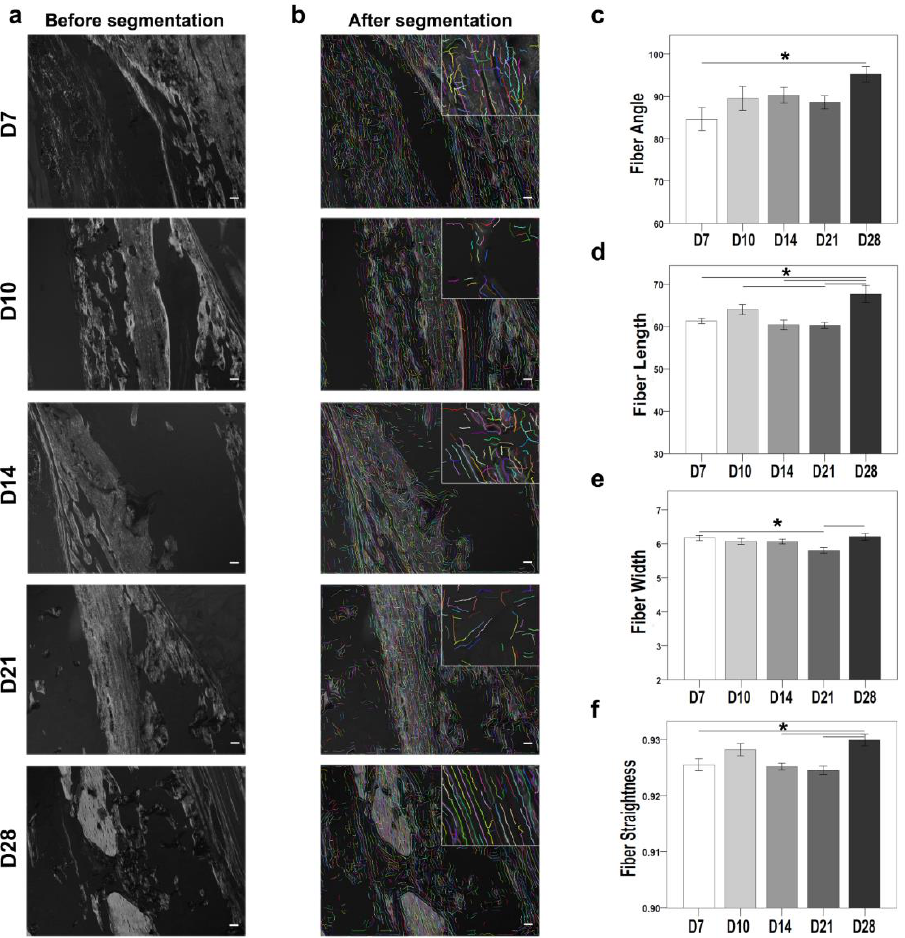
Figure 5. Quantitative evaluation of collagen fibril properties using the CT-FIRE plug-in showed enhanced bone quality at D28. CT-FIRE, a standalone MATLAB-based tool, was used to quantify the collagen fibers from polarized microscope Sirius red-stained images. ( a ) Before segmentation; ( b ) After segmentation. The right upper side shows the enlarged collagen fibers ( c – f ) D28 showing higher fiber angle, length, width, and straightness compared with D7, D10, D14, and D21. (N; D7 = 4, D10 = 6, D14 = 3, D21, D28 = 5; nonparametric distribution, Mann-Whitney U-test, * = p ≤ 0.05, scale bar: 50 µm).